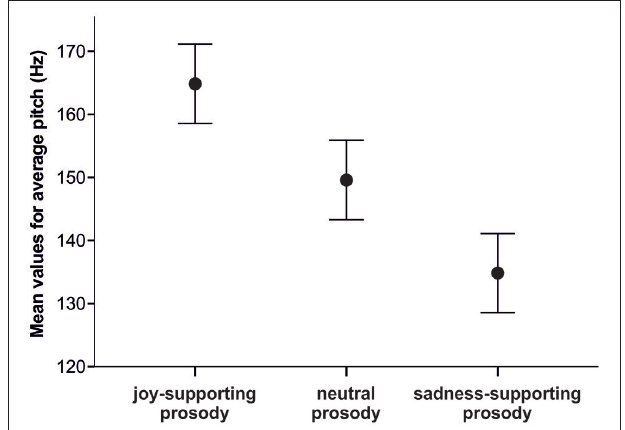
FIGURE 1 | Chart showing mean values of averaged pitch values in Hertz for the three prosodic versions (joy-supporting prosody, neutral prosody, sadness-supporting prosody). Error bars indicate the 95% confidence